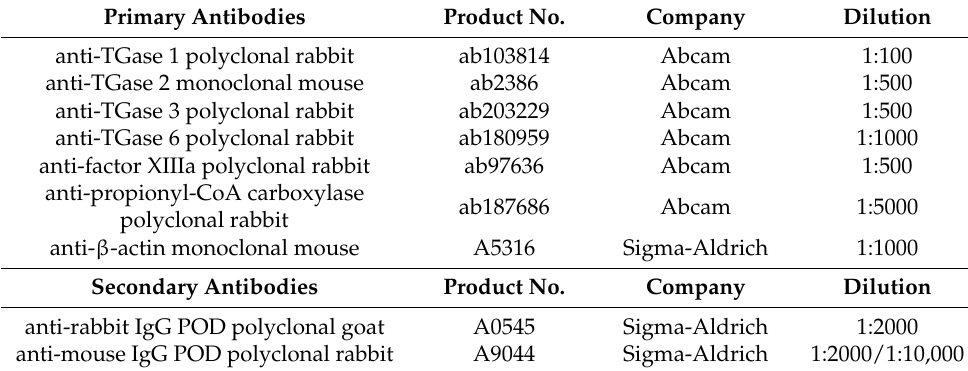
Table 6. Antibodies used for Western blot